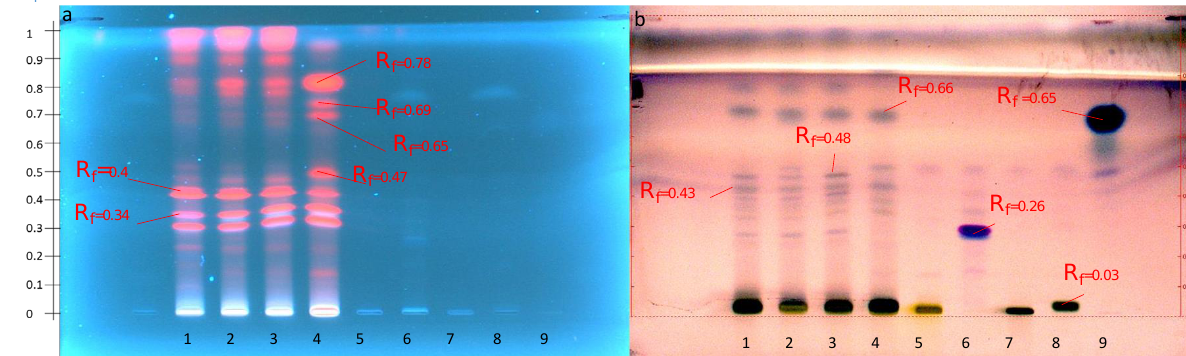
Figure 2. HPTLC profiles of the four extracts of the four populations obtained according to the M1 extraction method compared with the standards: ( a ) before visualization at 366 nm and ( b ) after visualization with anisaldehyde-H 2 SO 4 under white light according to the S1 elution system. Track 1, Bizerte; Track 2, Kairouan; Track 3, Zaghouan; Track 4, Siliana; Track 5, solanine; Track 6, senegenin; Track 7, digitonin; Track 8, glucose-fructose; Track 9, oleanolic acid.